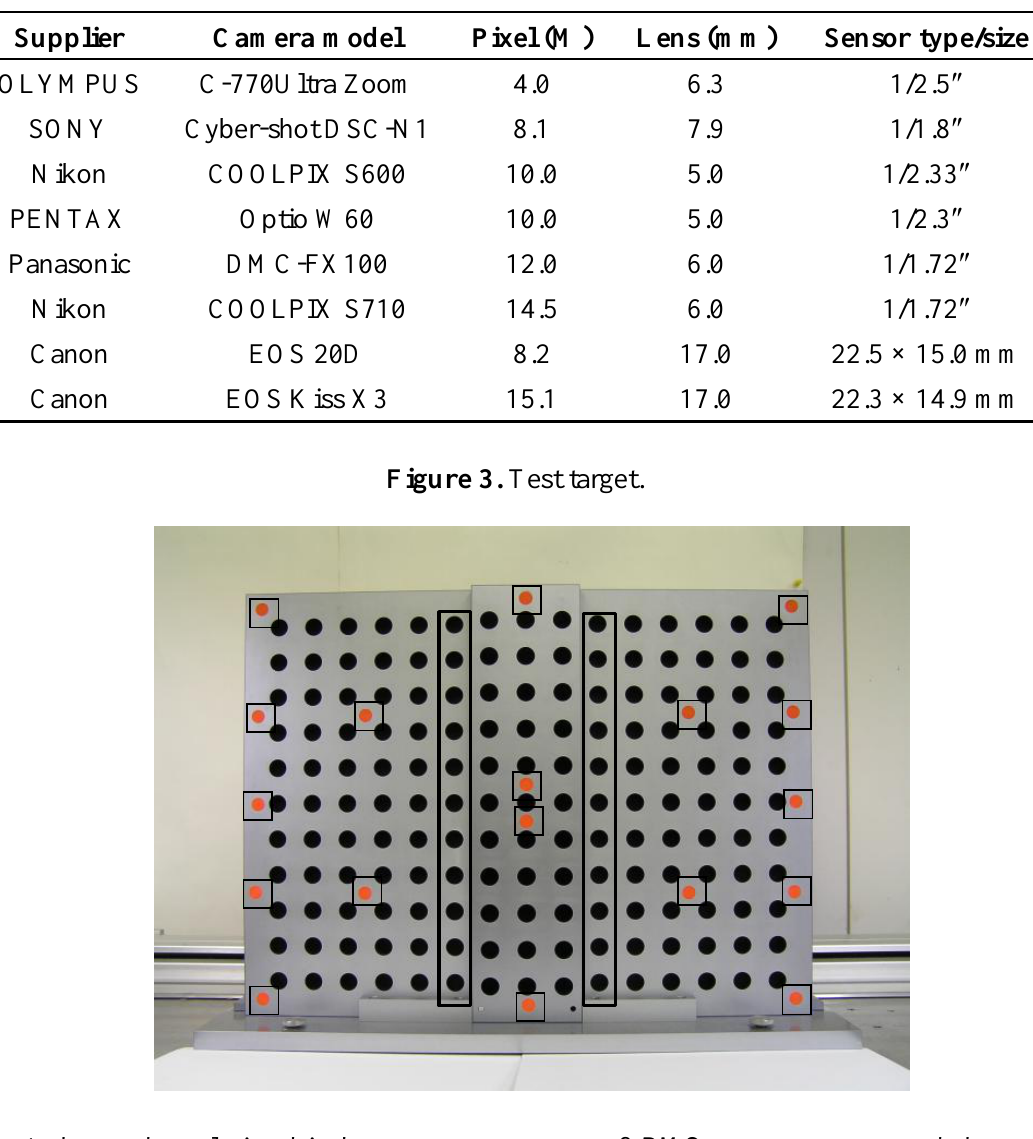
Table 1. Specifications of digital